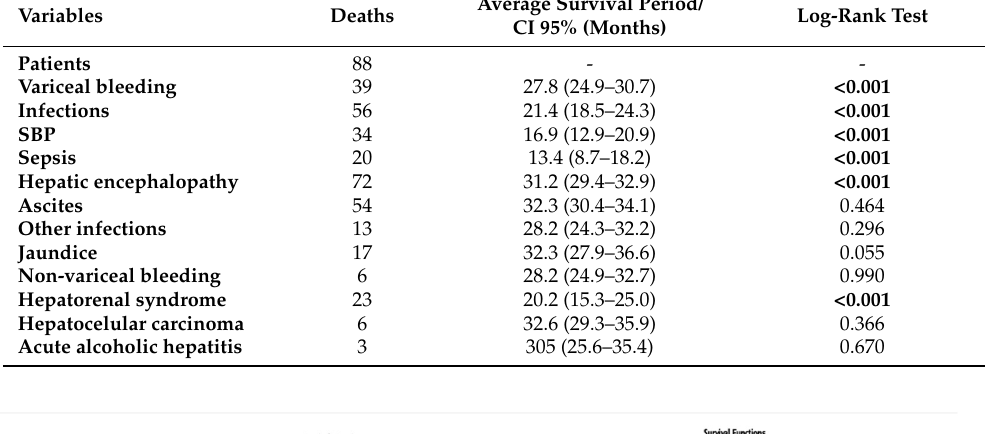
Table 6. The average survival period in patients with alcoholic liver cirrhosis depending on complications.